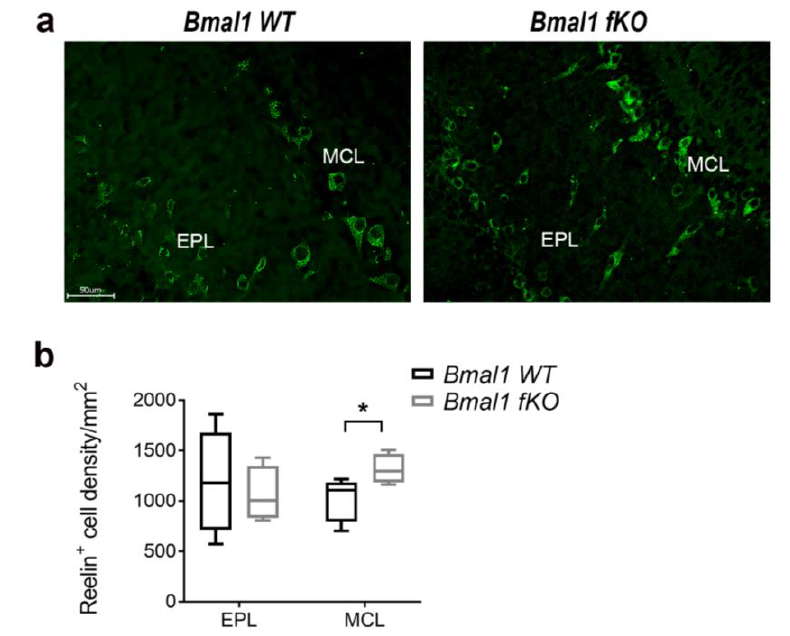
Figure 8. Reelin-immunoreaction in the olfactory bulb of Bmal1 fKO mice. ( a ) Representative Reelin-immunoreaction in the external plexiform layer (EPL) and the mitral cell layer (MCL) of the olfactory bulb. Scale bar = 50 µ m. ( b ) Quantitative analysis revealed a higher density of Reelin + cells in MCL (* p < 0.05) but not in the EPL of Bmal1 fKO ( n = 4) as compared to Bmal1 WT ( n = 5) mice.